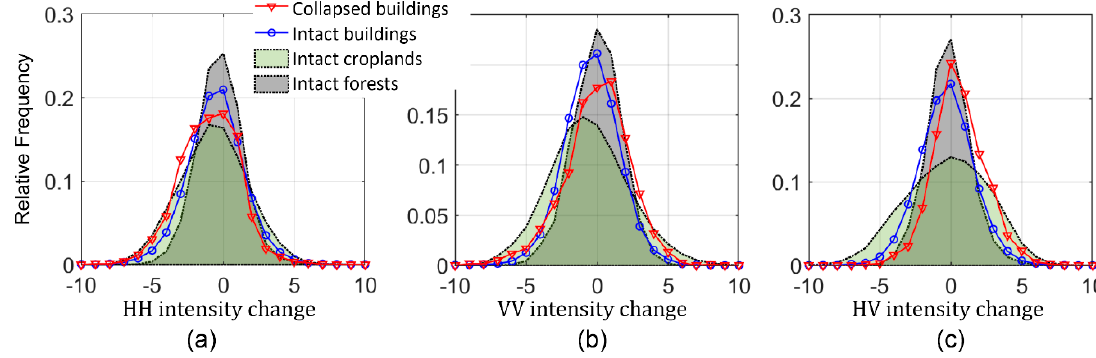
Figure 2. Histograms of scattering power changes in ( a ) HH-, ( b ) VV-, and ( c ) HV-polarization